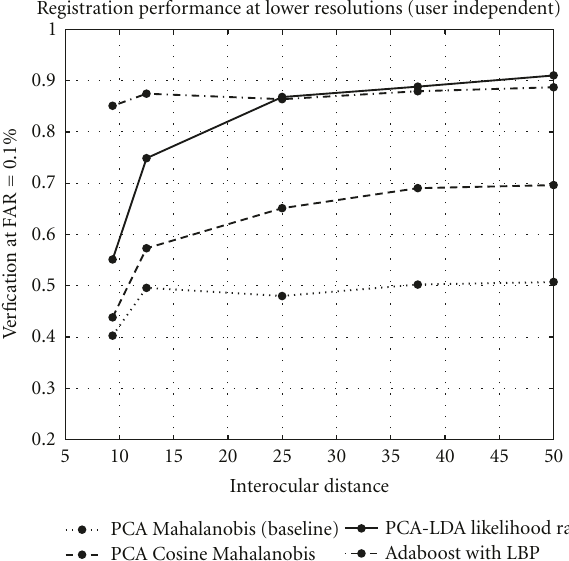
Figure 12: Registration performance by varying the resolution used in SHR, the found registration parameters are then used to align facial images with an interocular distance of 50 pixels, showing only the performance of SHR at low-resolution, which is still good at an an interocular distance of 25